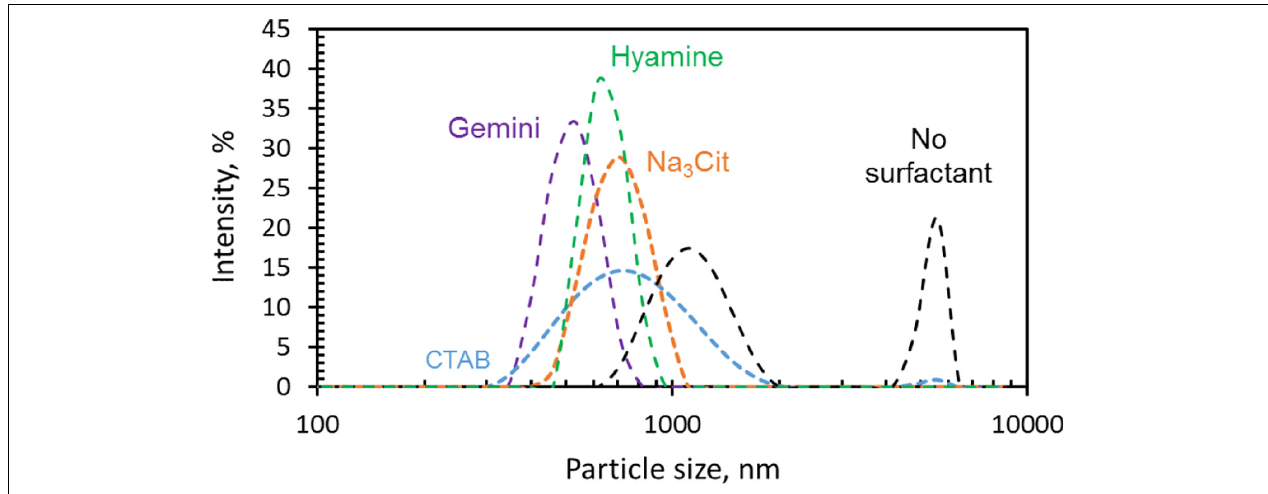
FIGURE 6 | DLS measurement of Ca-DTPMP particles prepared with and without surface surfactant.